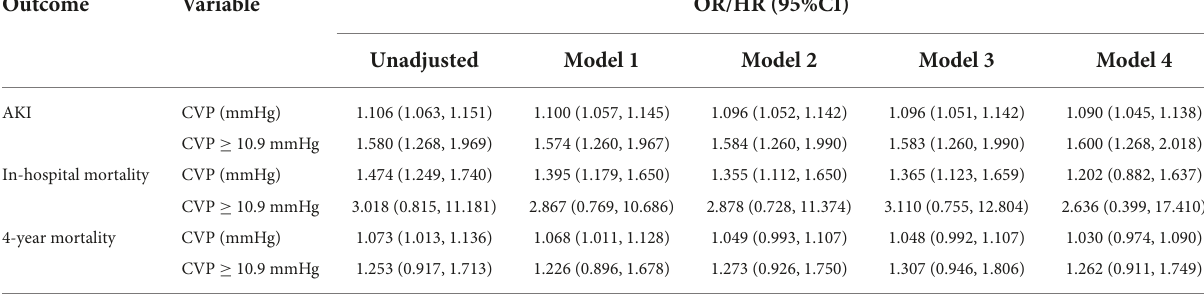
TABLE 4 Association of postoperative CVP with AKI and mortality after propensity score